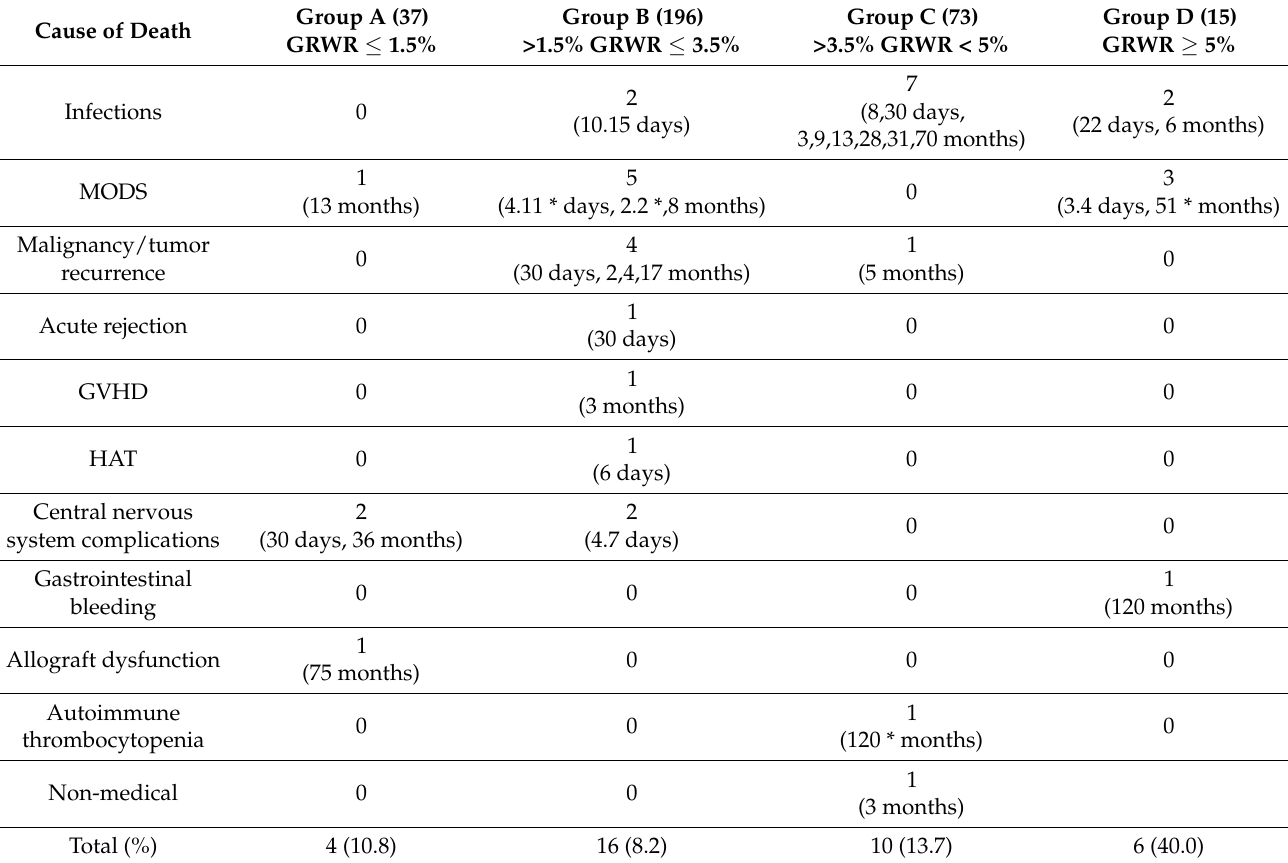
Table 8. Causes and time (days or months) of patient